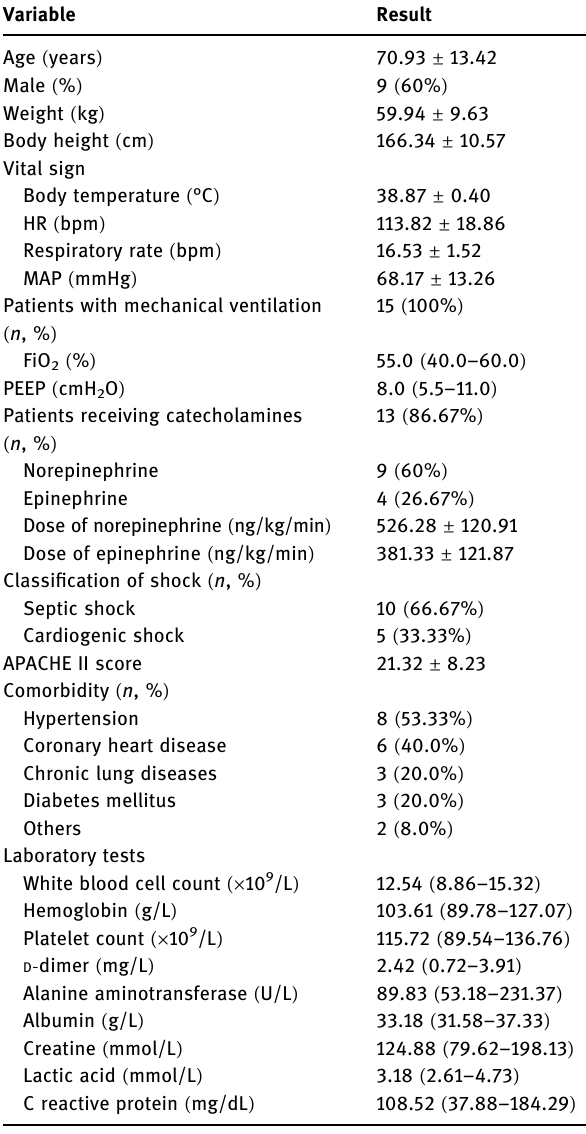
Table 1: Demographics, laboratory tests, vascular access, and ventilator parameters of included patients ( n = 15